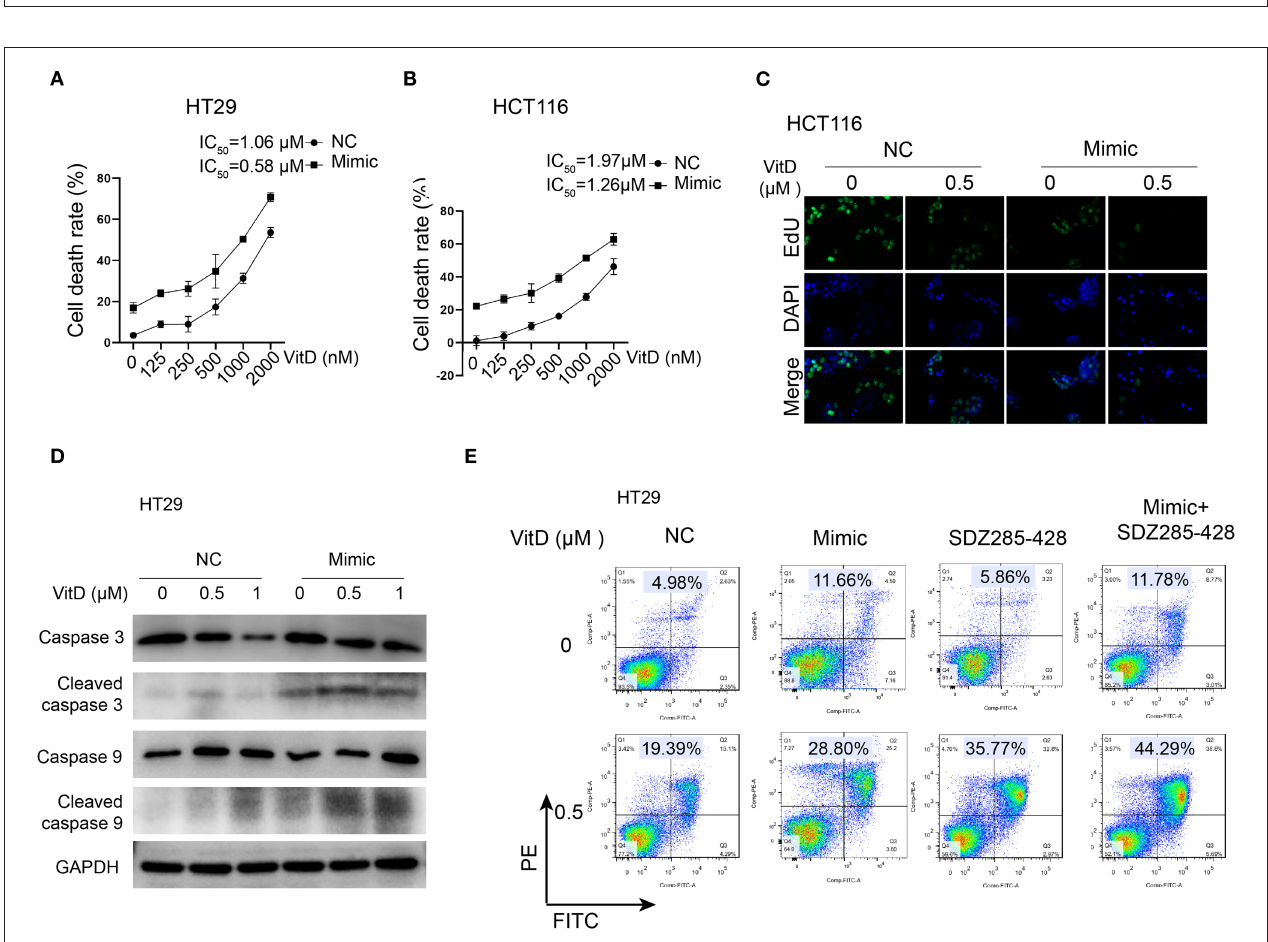
FIGURE 5 | detected by immunofluorescence and Western blotting. DNA damage was greatly enhanced in cells transfected with the miR-1278 mimic after oxaliplatin treatment. (G) An alkaline comet assay was used to detect single-stranded and double-stranded DNA damage. The results showed that overexpression of KIF5B markedly rescued miR-1278-mediated DNA damage after oxaliplatin treatment by decreasing single-stranded and double-stranded DNA damage. (H) Detection of the expression levels of caspase 3, cleaved caspase 3, caspase 9 and cleaved caspase 9 in the control, miR-1278 mimic, KIF5B overexpression and miR-1278 + KIF5B overexpression groups. Overexpression of KIF5B rescued miR-1278-mediated apoptosis after oxaliplatin treatment in HT29 and HCT116 cells. (I) Overexpression of KIF5B markedly decreased the apoptosis rate from 28.34% in the miR-1278 group to 21.66% after 20 µ M oxaliplatin treatment in HT29 cells. NC,